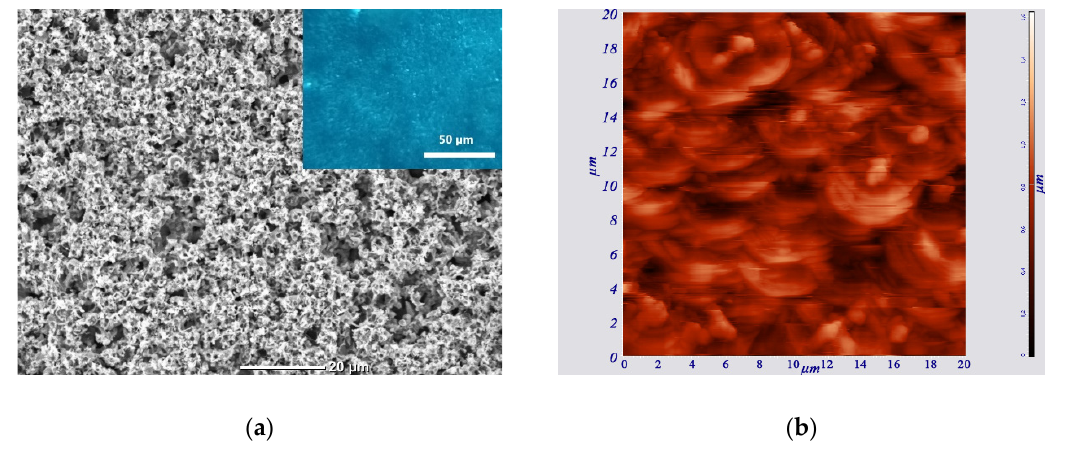
Figure 4. Planar images of the reverse side of the N1 film, obtained using: ( a ) SEM (the inset shows an optical microscopy image obtained in the transmission mode) and ( b ) AFM.